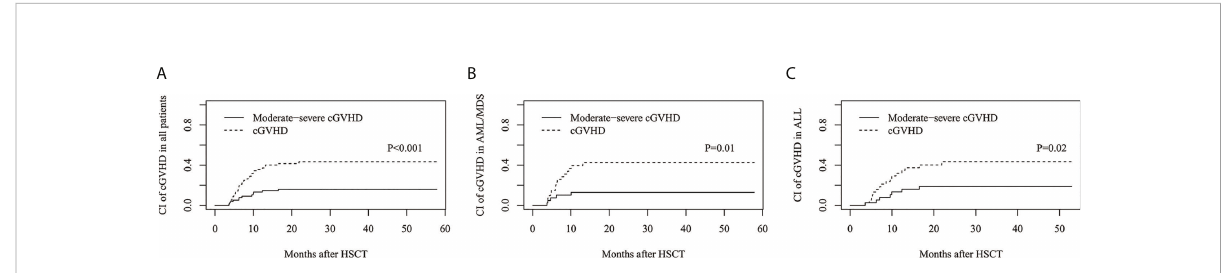
FIGURE 2 The estimated CI of chronic GVHD (cGVHD). CI of cGVHD and moderate-severe cGVHD in (A) all patients, (B) AML/MDS and (C)